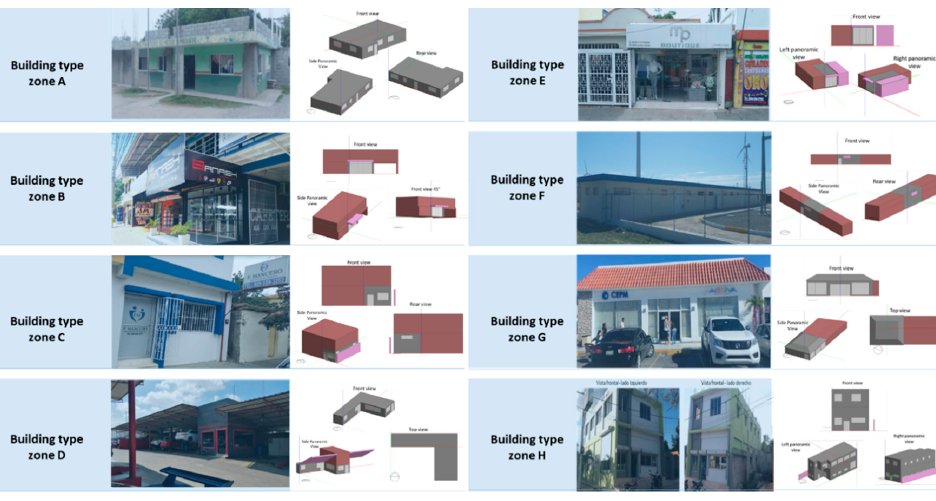
Figure 4. View of building types for each area of the case under